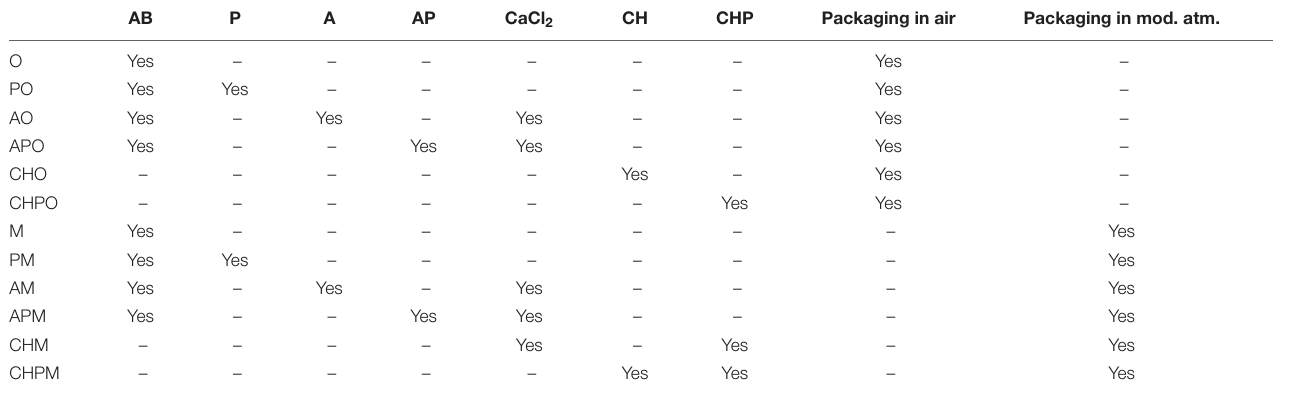
TABLE 2 | Sample preparation. The ratio fruit pieces/solution was 5 pieces in 200 ml of dipping